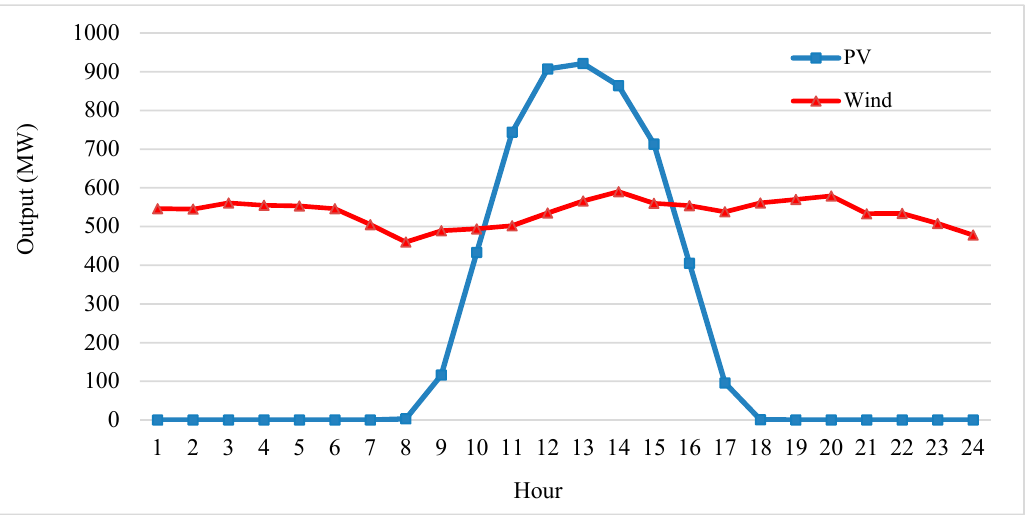
Figure 4. Output profiles of the selected VGRs (i.e., wind and PV systems) for the peak-load day.